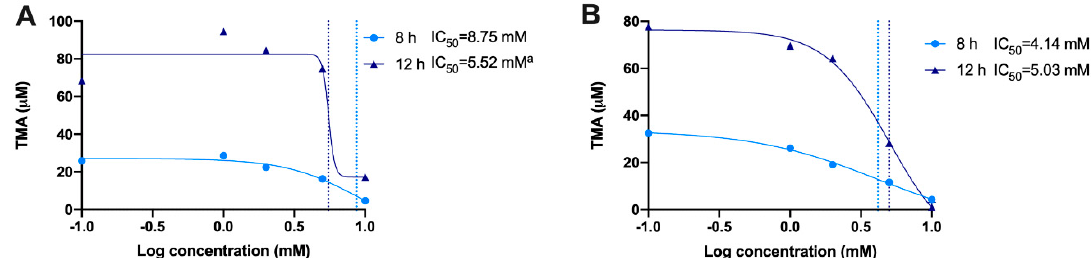
Figure 10. Calculation of IC 50 for gallic acid ( A ) and chlorogenic acid ( B ) at 8 and 12 h. IC 50s were calculated using a 4-factor sigmoidal fitting with interpolation of concentrations producing 50% of maximum TMA levels (mean TMA production from n = 6 replicates was used). a Ambiguous IC 50 .